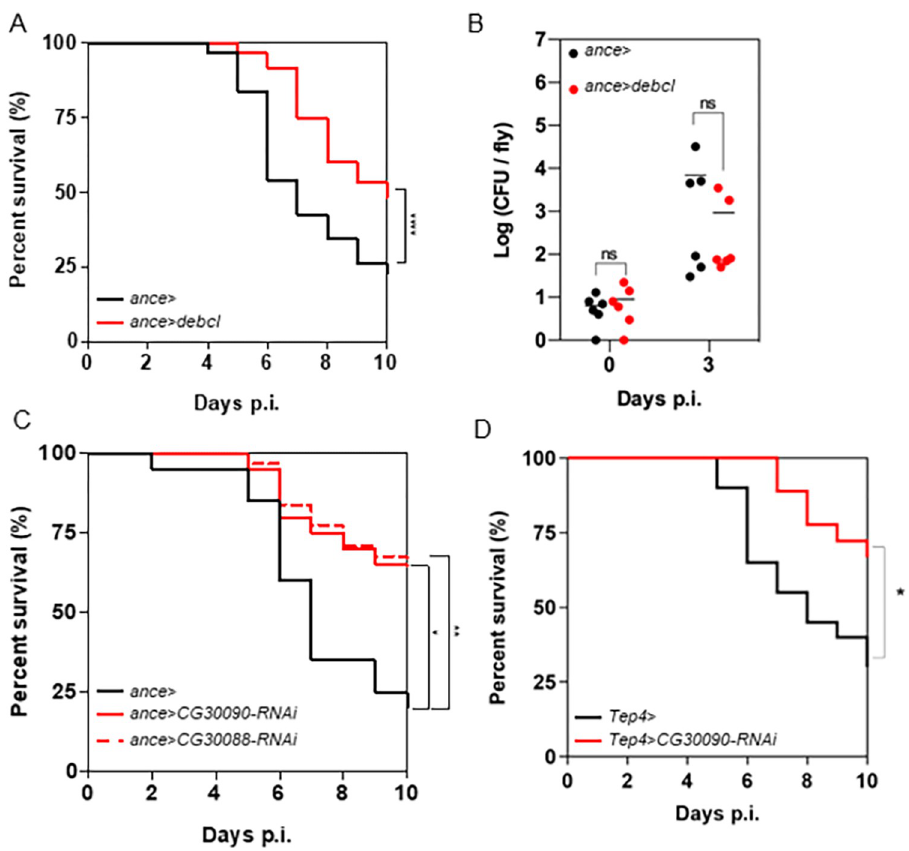
Fig 5. M . abscessus resists CG30090-mediated lysis of phagocytes by thanacytes. (A) Survival curves of ance > and ance > debcl flies injected with 10 CFU of M . abscessus . (B) Bacterial load quantification at 0 and 3 days p.i. by CFU counting of ance > and ance > debcl flies injected with 10 CFU of M . abscessus . (C) Survival curves of ance > , ance > CG30090-RNAi and ance > CG30088-RNAi flies injected with 10 CFU (Colony Forming Unit) of M . abscessus . (D) Survival curves of Tep4 > and Tep4 > CG30090-RNAi flies injected with 10 CFU of M . abscessus . Survivals were analyzed in 40–60 flies per condition using long-rank test ( * p < 0.05; ** p < 0.005; **** p < 0.0001) (A, C, D). Bacterial loads were individually quantified on 6 flies per condition (B). Each point represents the CFU number of a fly, horizontal traits representing the mean CFU of a condition. Data were analyzed by two-way ANOVA test (ns = non- significant). phagocytic cells without killing the intracellular M . abscessus , and then, promote M . abscessus spreading. We then tested whether plasmatocytes infected by S. M. abscessus could be lysed. To do so, we measured the transcript levels of crq and nine additional genes (Mmp2, NimC2, CAH7, Robo2, Mbc, NimB4, NimB5, Nplp2, eater) described as highly expressed in plasmatocytes with phagocytic activity [39,42]. Their abundance would indirectly reflect phagocyte numbers in ance > and ance > CG30090-RNAi flies. On day 4 p.i., relative expres- sion levels of the ten genes were higher in infected ance > CG30090-RNAi flies compared to infected ance > (Fig 6A), relatively to uninfected flies of the two genotypes. These results sug- gest that the increased expression of these markers during infection, upon serine protease depletion, would be related to a larger phagocytic population, maintained during this infec- tion, unlike the control flies where this expression is reduced. The reduction in the infected phagocytic population might be through caspase-dependent apoptosis [46], with regards to the property conferred to thanacytes via the serine-protease activity [39].